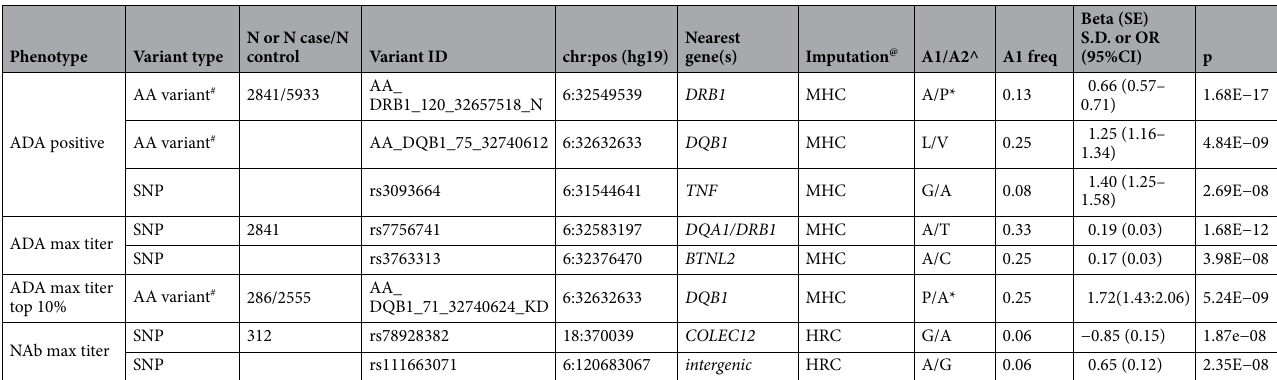
Table 1. Primary genome-wide significant associations for anti-drug antibody phenotypes. Index SNPs determined by clumping with LD R 2 = 0.1. # Notation is AA_gene_residue_nucleotide b.36_encoded amino acid(s) 21 @ Imputation using the genome-wide HRC panel (HRC) or the MHC panel (MHC). ^A1 = coded (i.e. effect) allele/A2 = non-coded allele, indicated as alternative single letter amino acid code for AA variants or alternative nucleotide for SNPs. *AA in variant ID present (P) or absent (A). Covariates were age, sex, study, PCs 1–5.